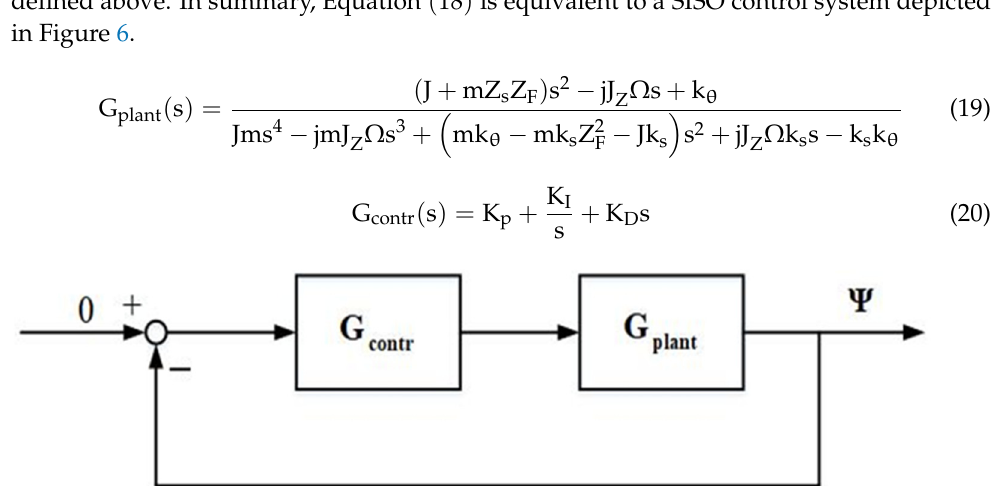
Figure 6. Block diagram of the equivalent SISO control system.